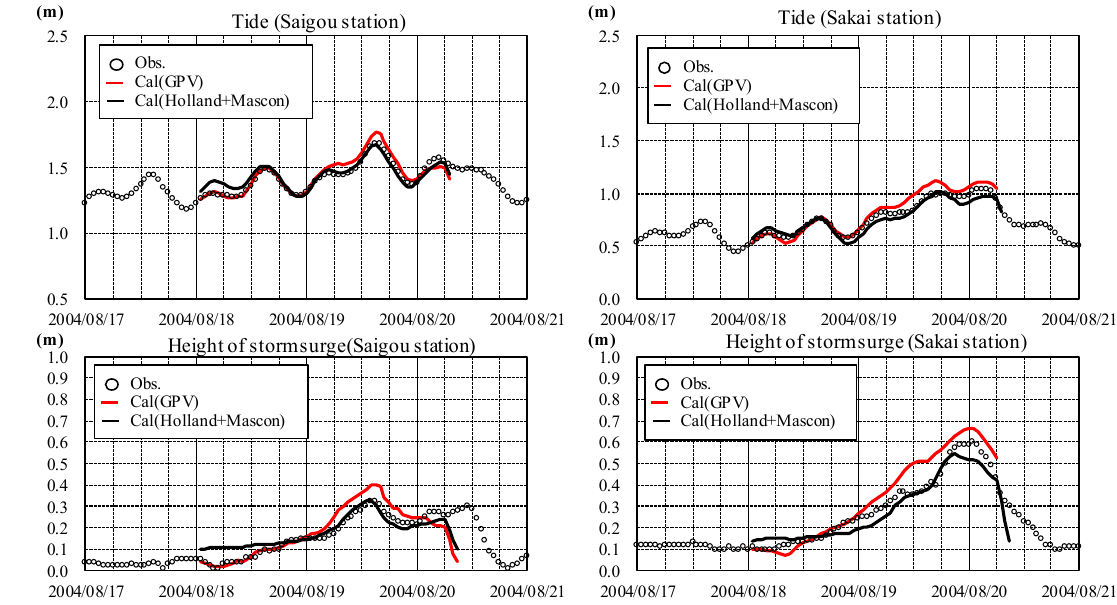
Figure 16. Verification results of the numerical simulation of the tide level and storm surge height.